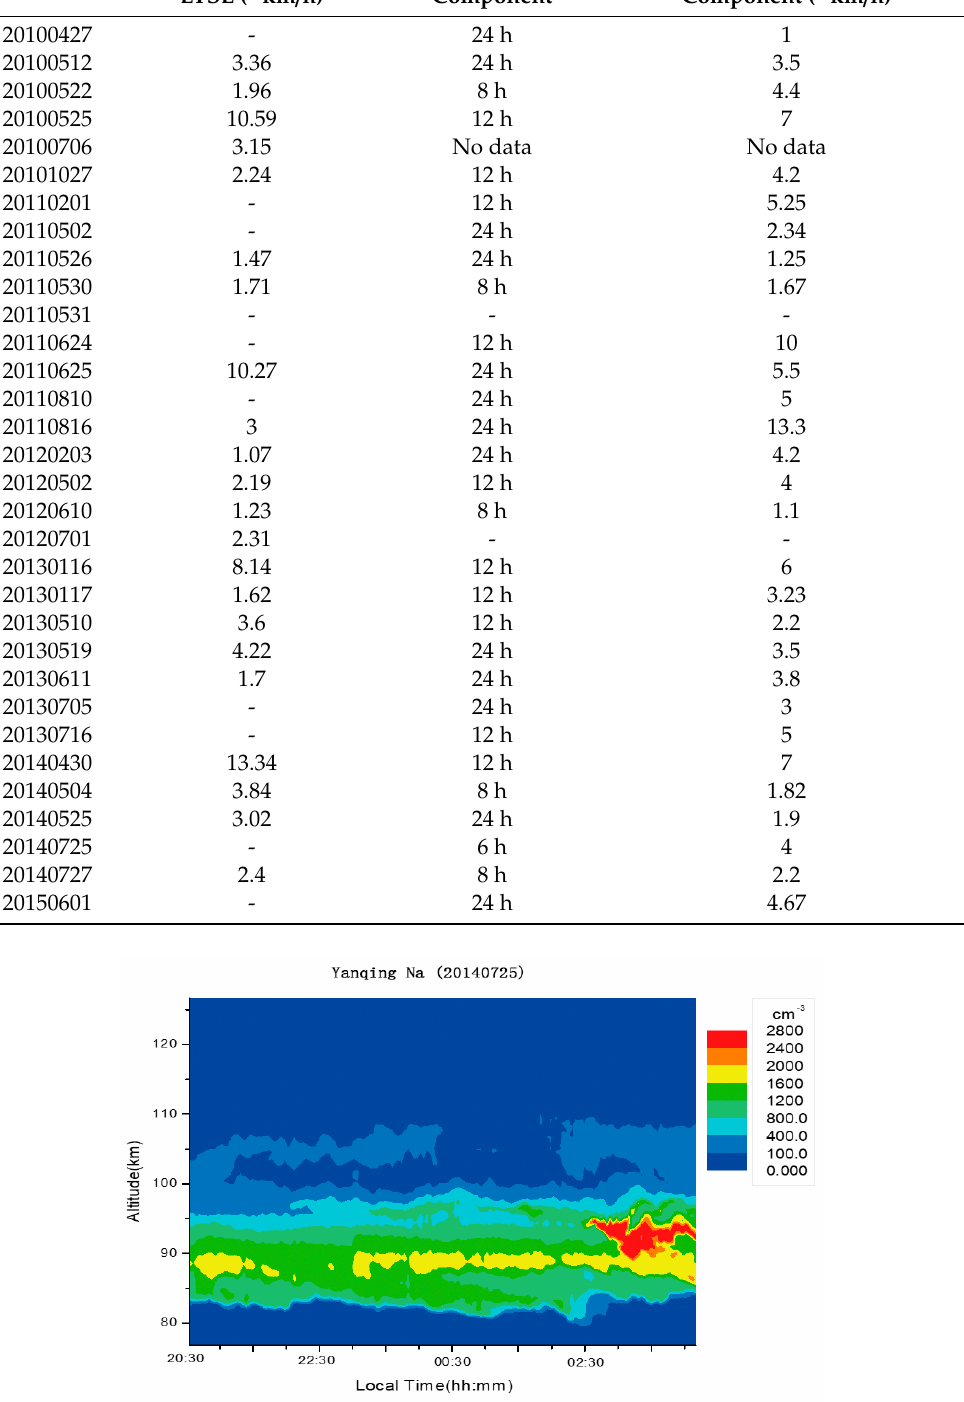
Figure 10. Time-altitude variations of the sodium densities on 25 July